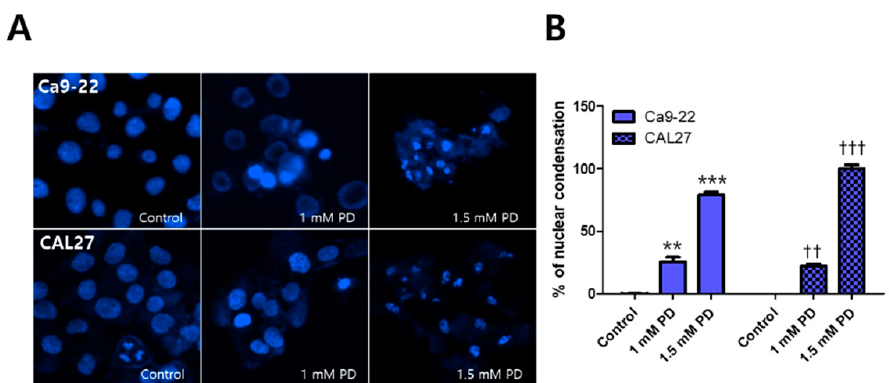
Figure 2. Polydatin-induced changes in nuclear morphology in OSCC cells. Ca9-22 and CAL27 cells were treated with 0, 1, and 1.5 mM polydatin. The nuclei morphology in both cell lines was observed through Hoechst staining. ( A ) The nuclear morphologies of Ca9-22 and CAL27 were observed and